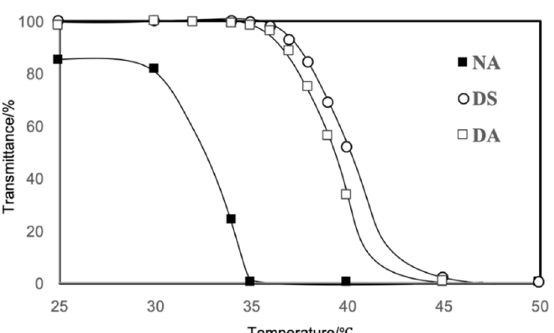
Figure 3. Transmittance ( λ = 600 nm) of the aqueous solutions of the copolymers.